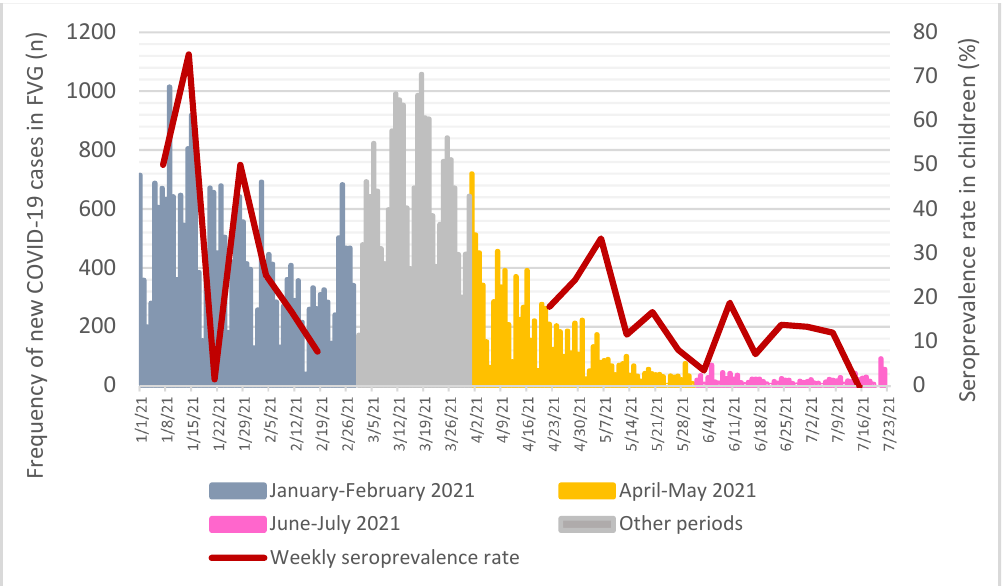
Figure 3. Seroprevalence rate on a weekly basis when compared to all-age new cases of COVID-19 assessed through nasopharyngeal swab in FVG Region. Data source for new COVID-19 cases: Pres- idency of the Council of Ministers, Civil Protection Department, data freely available at